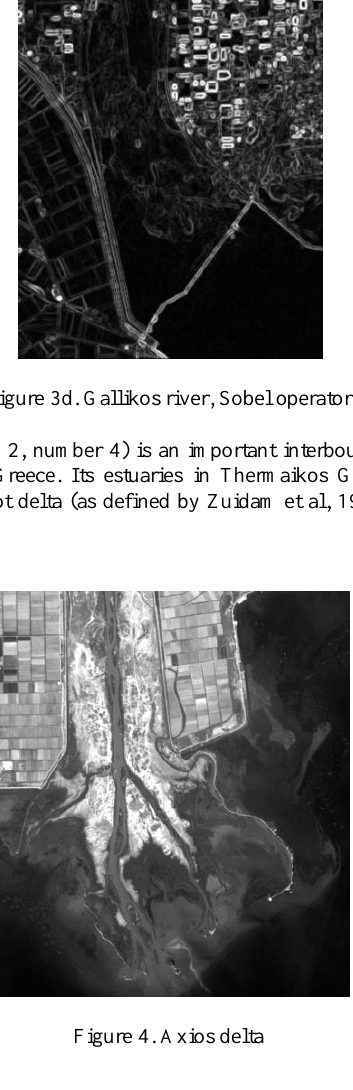
Figure 4. Axios delta